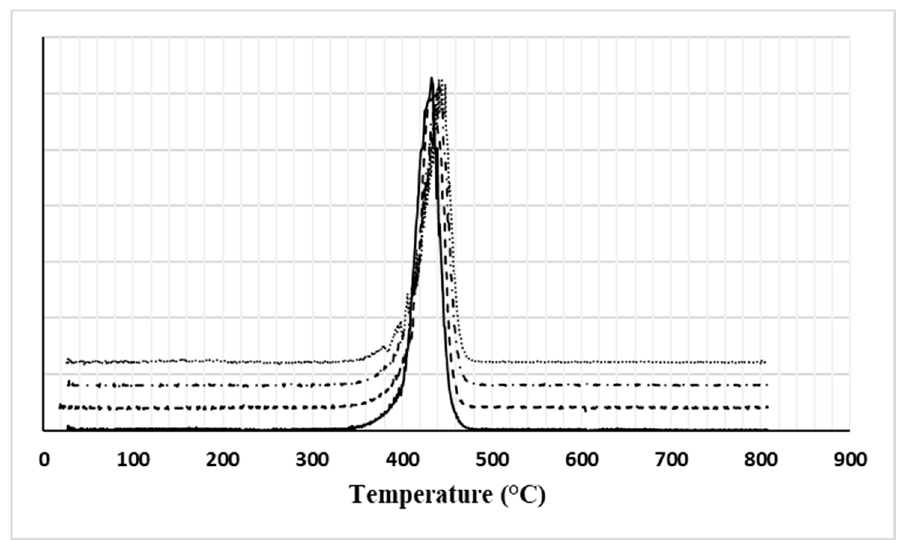
Figure 2. TG curves of all investigated materials (solid line: PA6, dashed line: PA6 + 1% GNP, dashed and dotted line: PA6 + 3% GNP, dotted line: PA6 + 5% GNP).